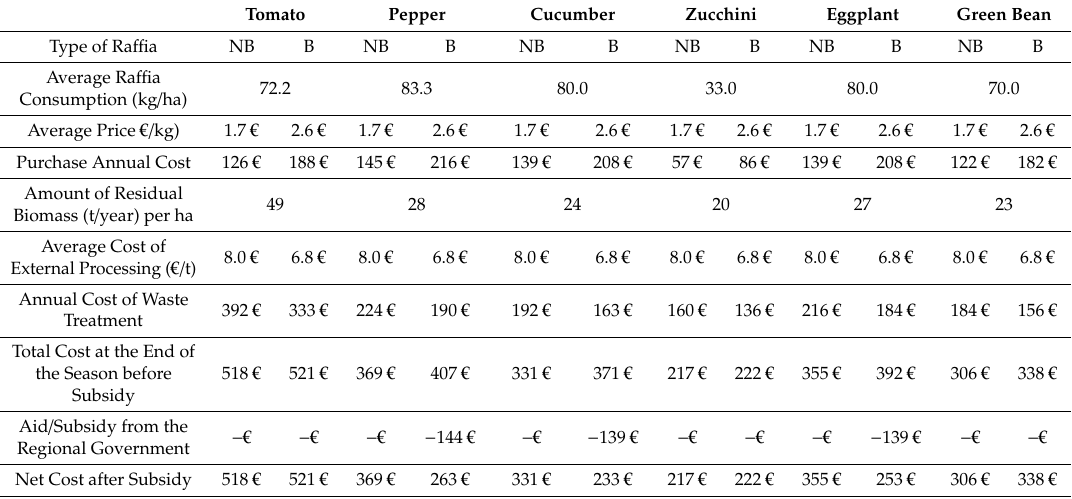
Table 4. Estimate of average total annual cost per hectare, type of ra ffi a, and type of crop. Year 2019. Tomato Pepper Cucumber Zucchini Eggplant Green Bean